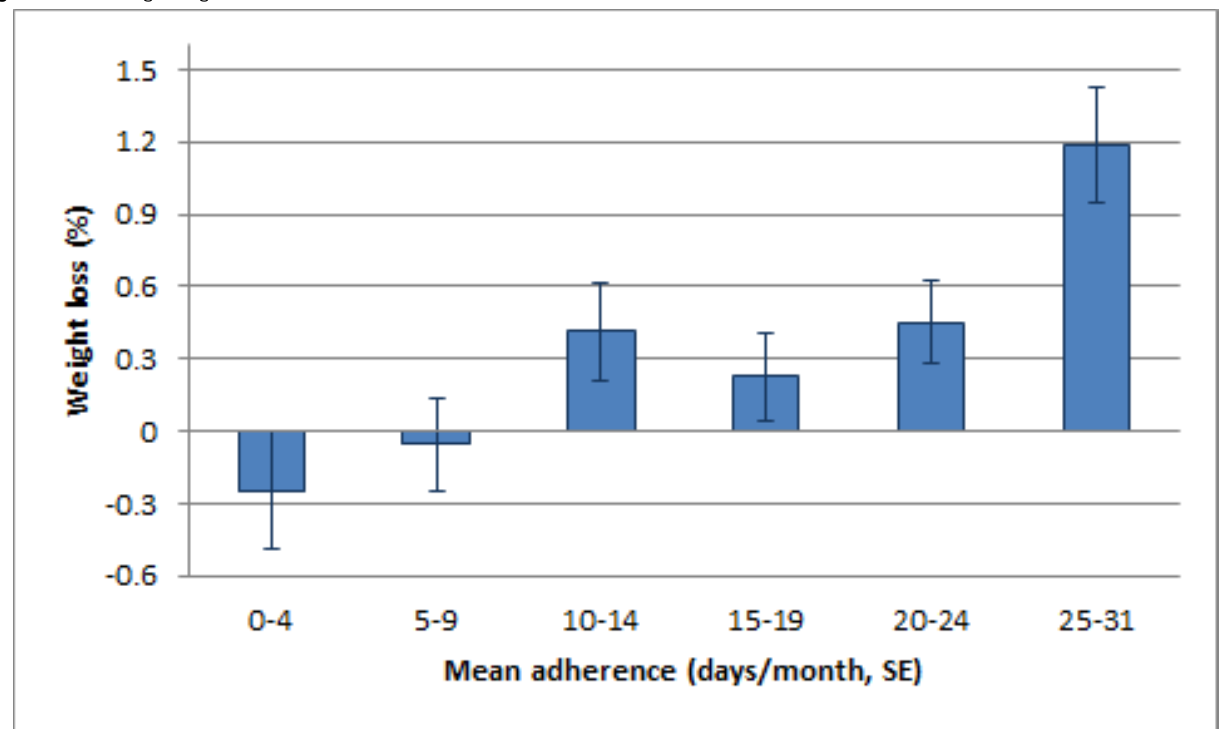
Figure 3. Percentage weight loss for different levels of